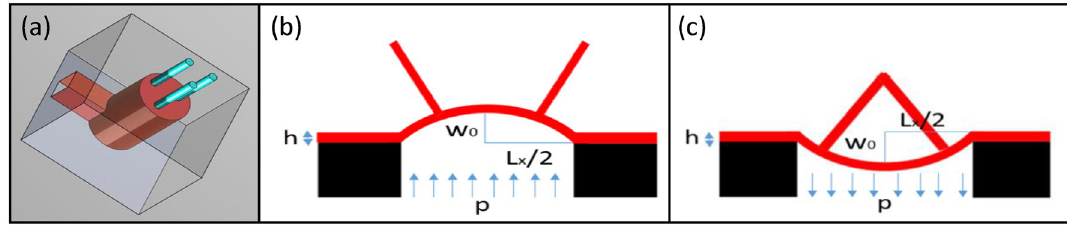
Figure 1. The designed microgripper with the fingers placed on the membrane and the opening/closing mechanism. ( a ) microgripper developed based on PDMS casting and is matched with microfluidics. The channel connected to the central void can be seen in this image. ( b ) Opening the fingers. ( c ) Closing the